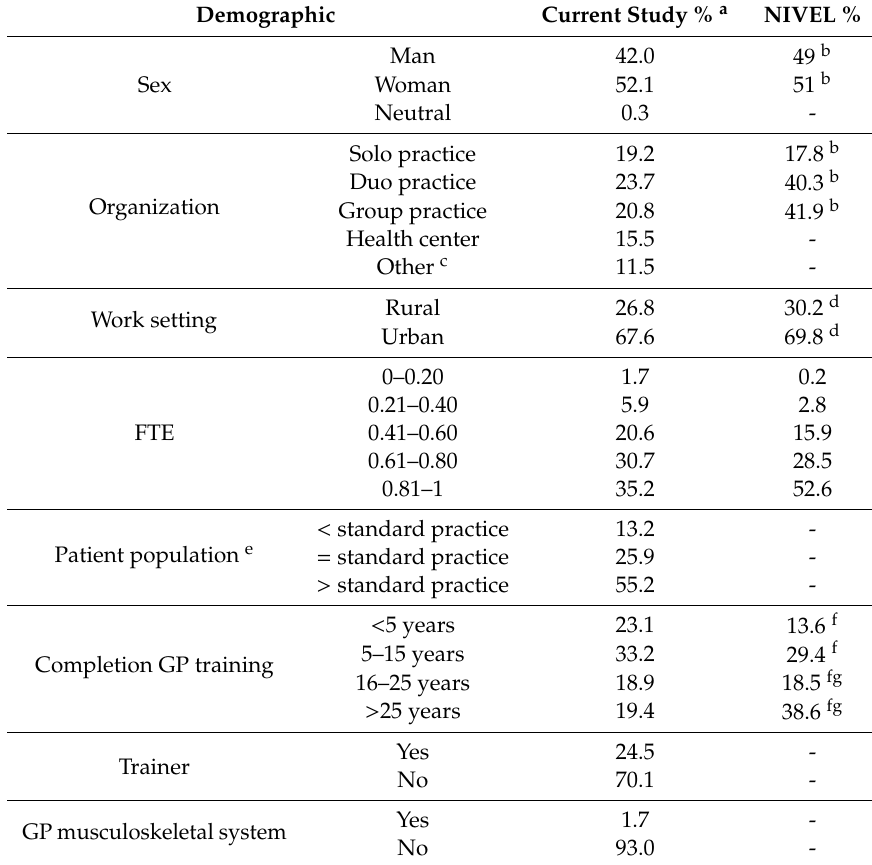
Table 1. Frequencies of demographics of the study and Netherlands Institute for Health Services Research